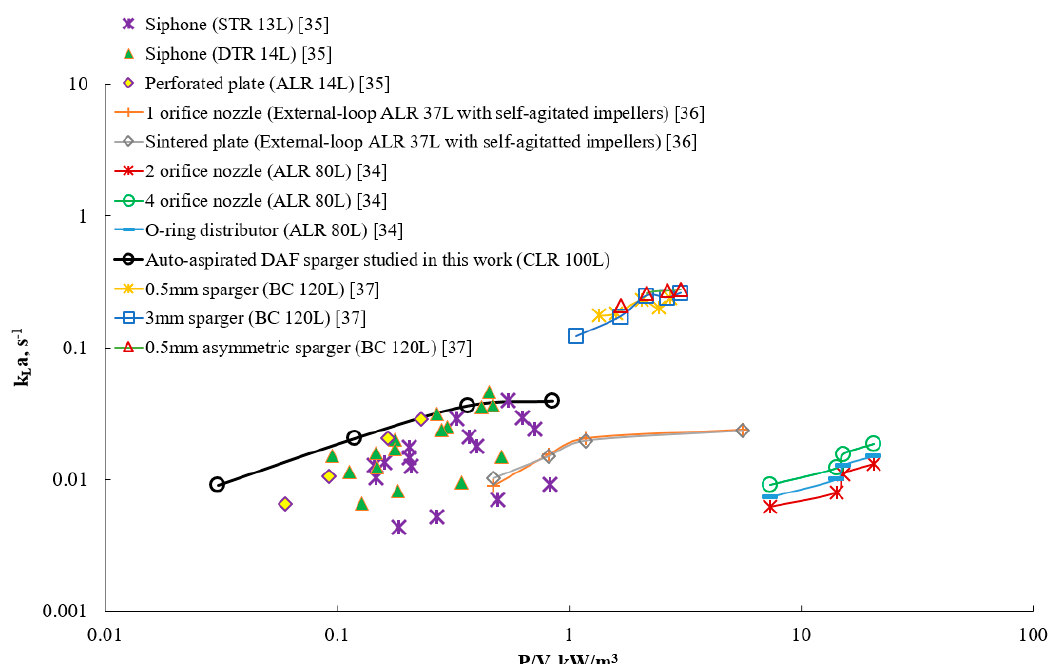
Figure 15. Comparison of the aeration efficiency achieved in the CLR with that of alternative spargers in various reactor configurations: closed-loop reactor (CLR), draft tube reactor (DTR), stirred tank reactor (STR), air-lift reactor (ALR), bubble column (BC) [34–37].